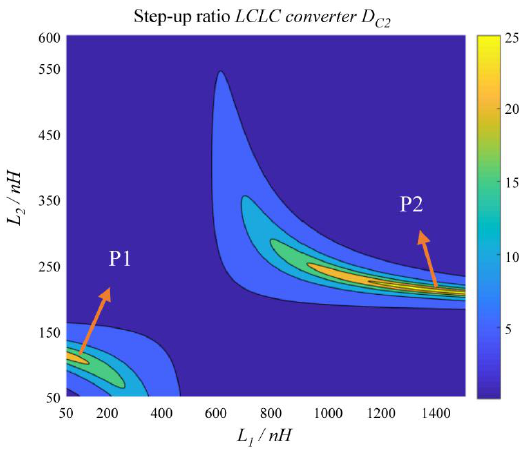
Figure 10. Effect of L1 and L2 on the step-up ratio D c2 .